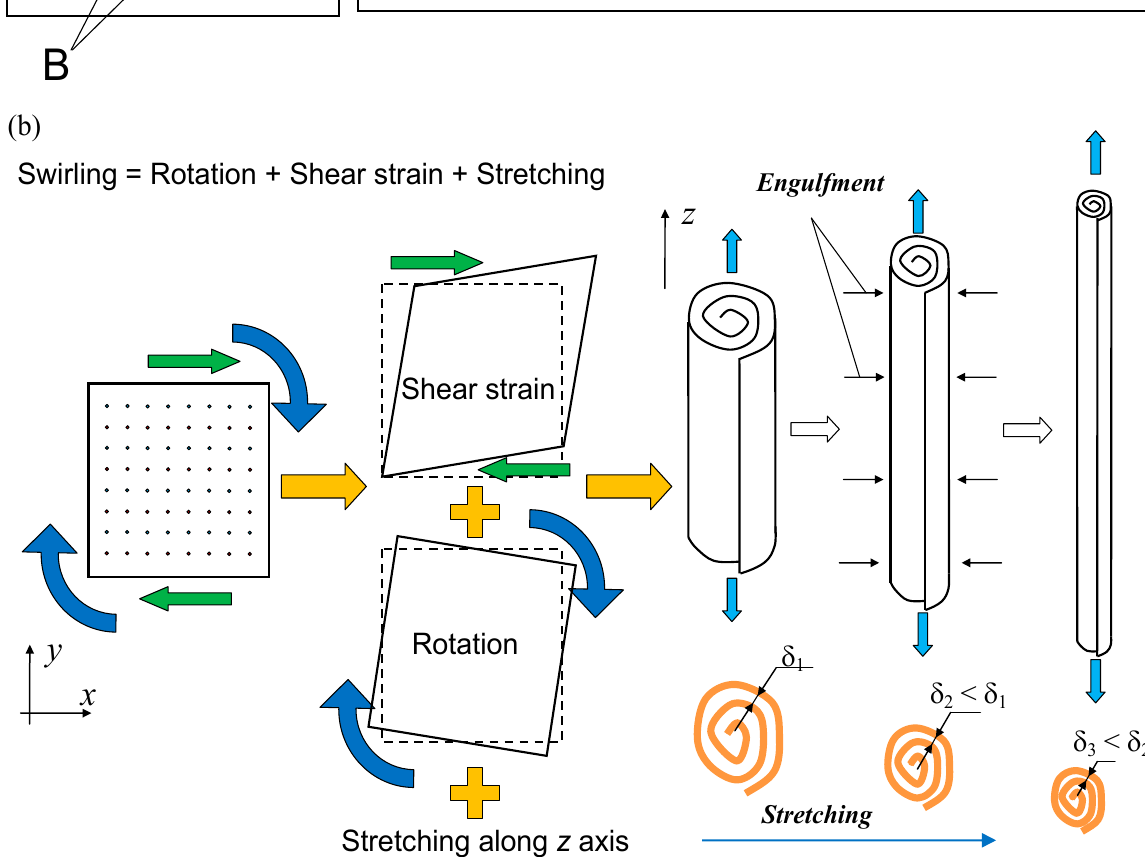
Figure 4. Schematic of the influence of linear ( a ) and angular deformations, as well as swirling (rotation) of the flow ( b ) on the process of diffusion of substances (micromixing), uniformly distributed over the volume.